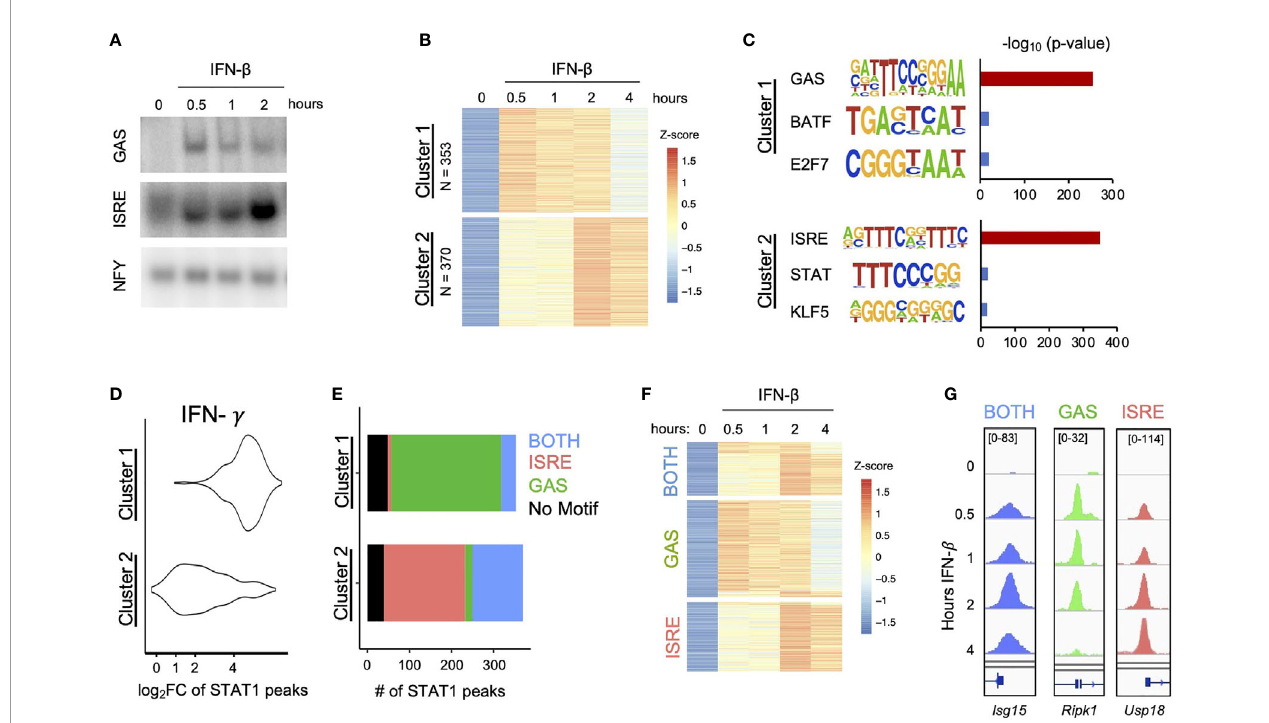
FIGURE 1 | IFN- b Induced STAT1 binds to GAS and ISRE motifs. (A) EMSA of GAS and ISRE binding in MLE12 cells treated with IFN- b (100 U/ml).NFY shown as loading control. Data are representative of >5 independent experiments. (B) STAT1 ChIP-seq heatmap of inducible STAT1 peaks (FDR< 0.01 for peak calling & > 2- fold induction in at least two time points) after IFN- b (10U/ml) stimulation. Peaks were clustered using k-means clustering. (C) Top three hits from de novo motif analysis on STAT1 peaks in Cluster 1 vs. 2 as de fi ned in (B) . (D) IFN- g (100 ng/ml) induced STAT1 ChiP-seq signal comparing locations in Cluster 1 vs. 2. (E) Stacked bar graph of number of peaks per Cluster that contain ISRE, GAS, or BOTH motifs by searching the HOMER database (see Figure S1 ). (F) Re-clustered STAT1 ChIP-seq heatmap based on motif categories. (G) Genome browser tracks of representative promoter-bound STAT1 ChIP-seq peaks from BOTH ( Isg15 ), GAS (Ripk1) , and ISRE ( Usp18 ) categories.